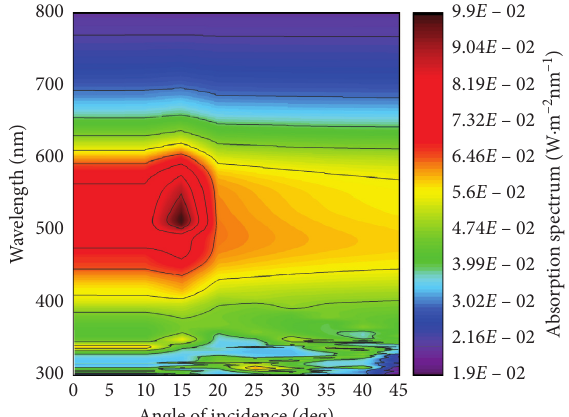
Figure 6: Map of the absorption in the OSC versus wavelength ( λ ) and incidence angles ( θ